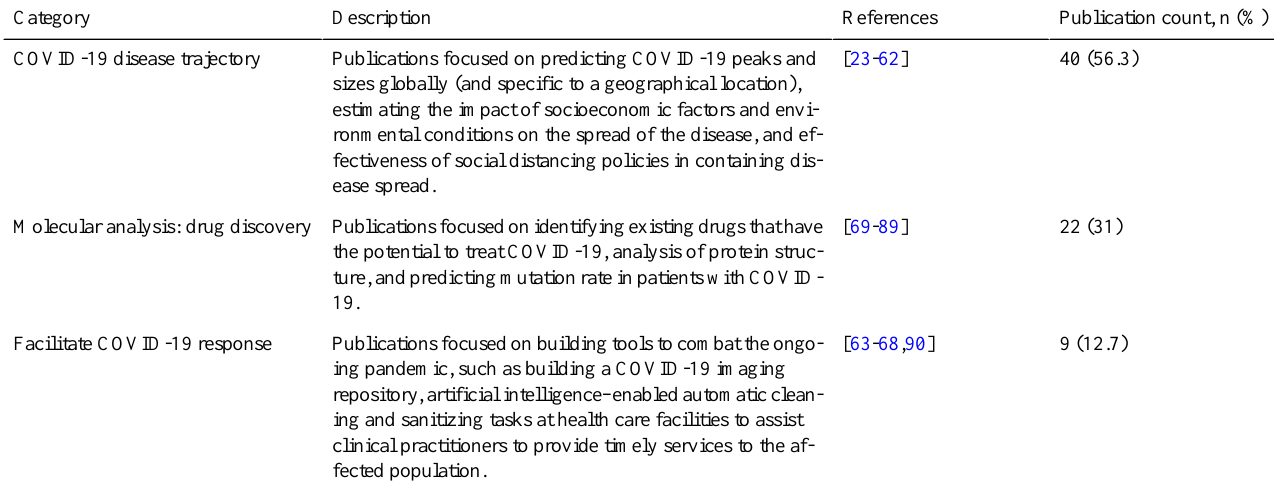
Table 2. Computational Epidemiology publications (n=71) subclassified into 3 categories: (1) COVID-19 disease trajectory, (2) molecular analysis-drug discovery, and (3) facilitate COVID-19 response.